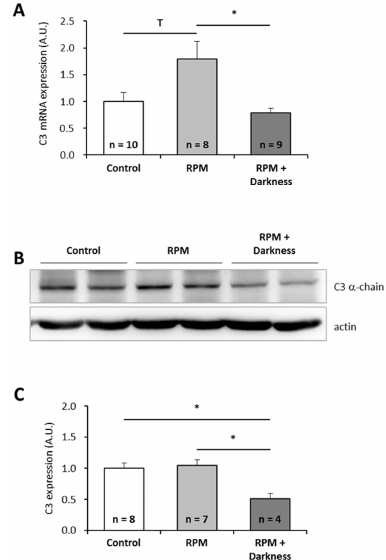
Figure 3. Effects of the combination of simulated microgravity and darkness on P. waltl complement C3 expression. ( A ) C3 mRNA were quantified by RT-qPCR. ( B, C ) C3 proteins were quantified by western blotting. Western blot results were visualized by chemiluminescence, analyzed by densitometry, and normalized to α-actin. Relative values obtained with control larvae placed in a miniaquarium positioned on the base of the random positioning machine (RPM) and subjected to normal light conditions were set to one in ( A ) and ( C ). Results are expressed as means ± SEM. “A.U.” stands for “arbitrary units”. Differences were found using Kruskal–Wallis followed by a Dunn test ( A ) or ANOVA followed by a Tukey–Kramer test ( C ). * p < 0.05, T indicates a tendency (statistically significant difference with a 10% alpha risk but not with a 5% alpha risk), NS., no statistical difference.